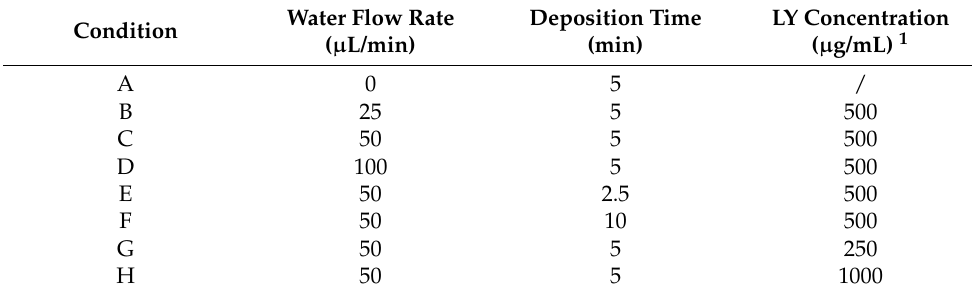
Table 1. Different conditions used during the aerosol-assisted atmospheric pressure plasma depo- sition by varying the water flow rate injected in the nebulizer, the deposition time and the Lucifer Yellow concentration in the water for the deposited agent quantification